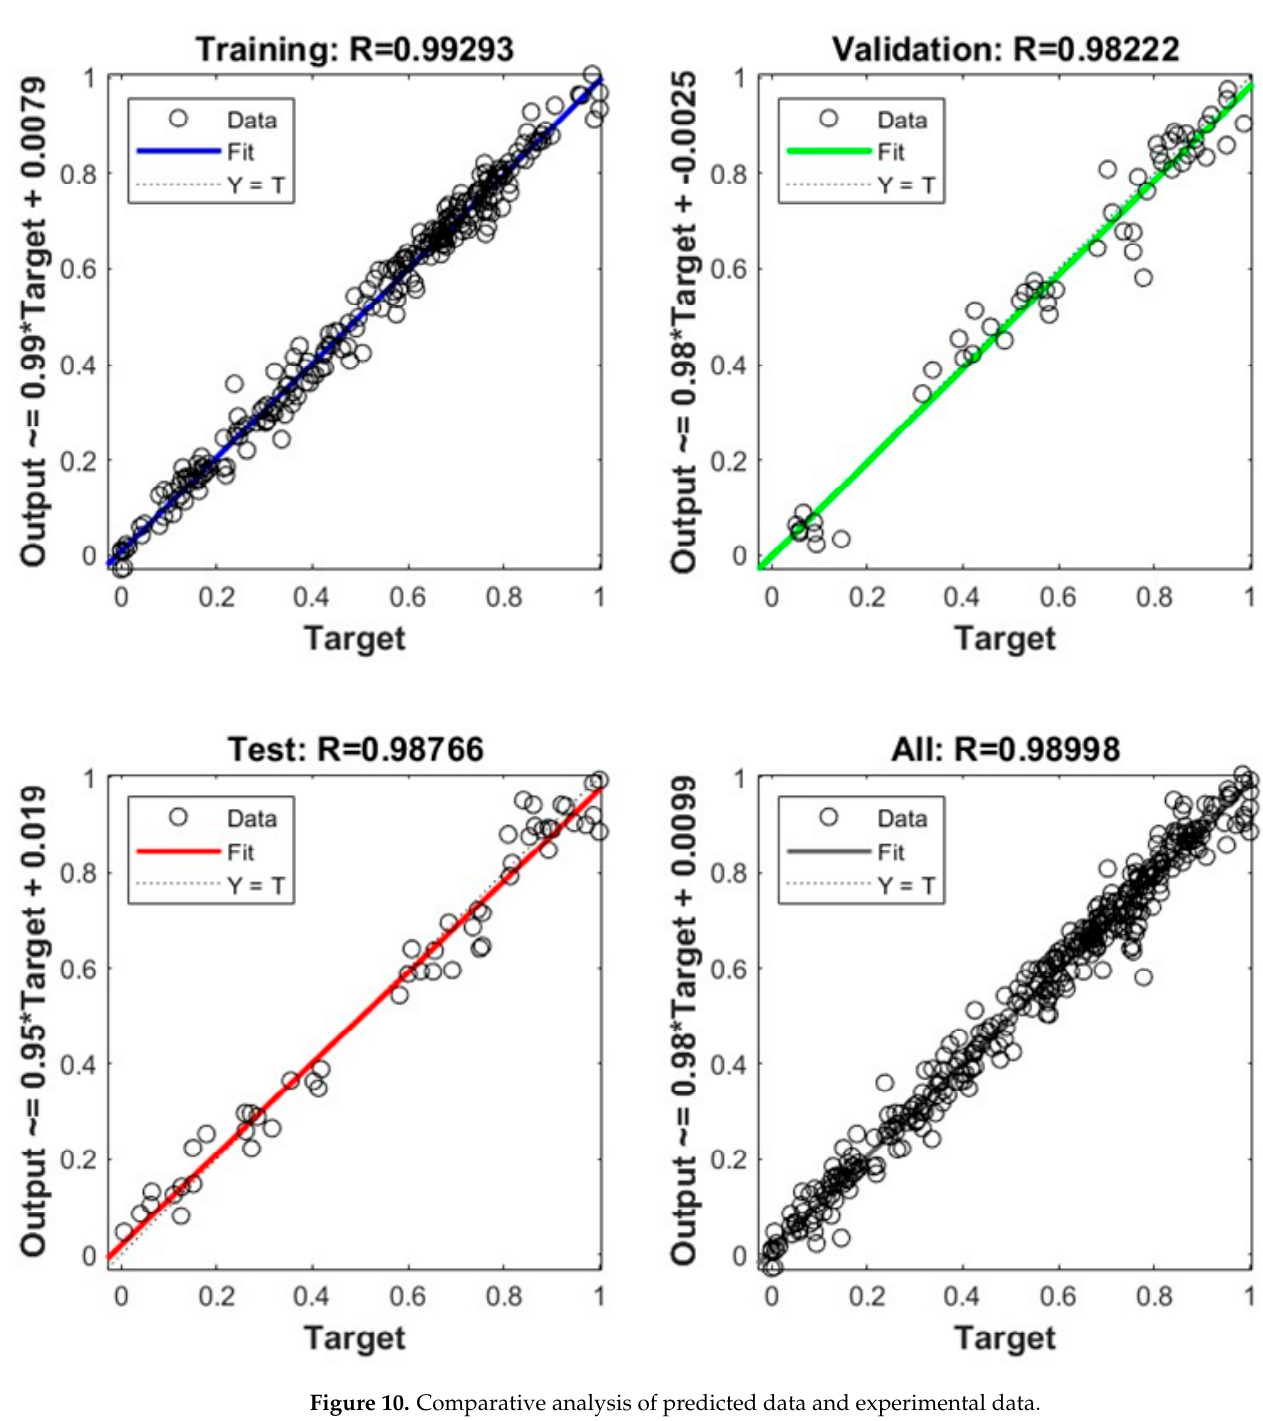
Figure 10. Comparative analysis of predicted data and experimental data.